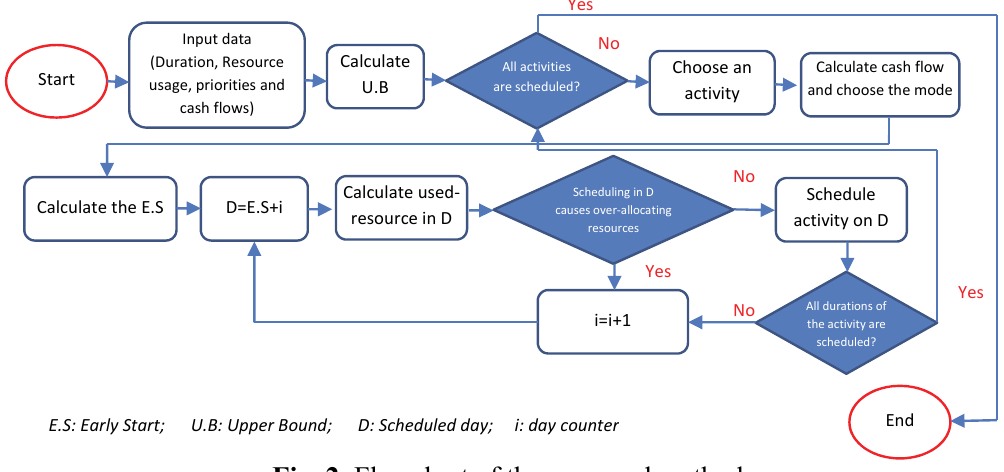
Fig. 2. Flowchart of the proposed